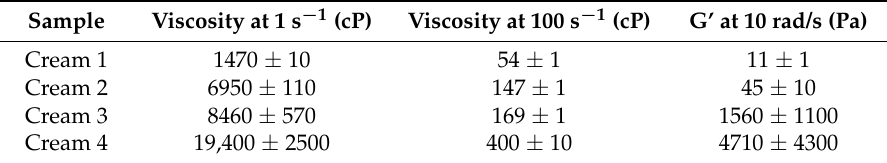
Table 5. Viscosity and storage modulus (average ± SD) of the creams at room temperature.